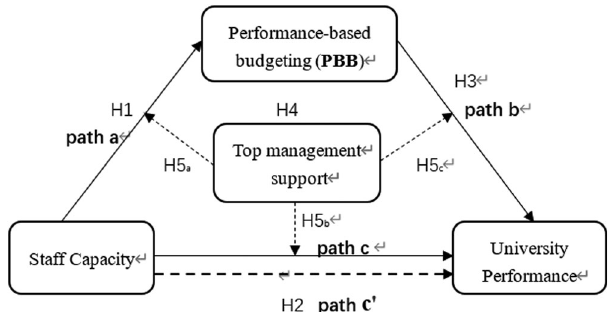
Fig. 1 Research model. A description of the relationship between variables in the